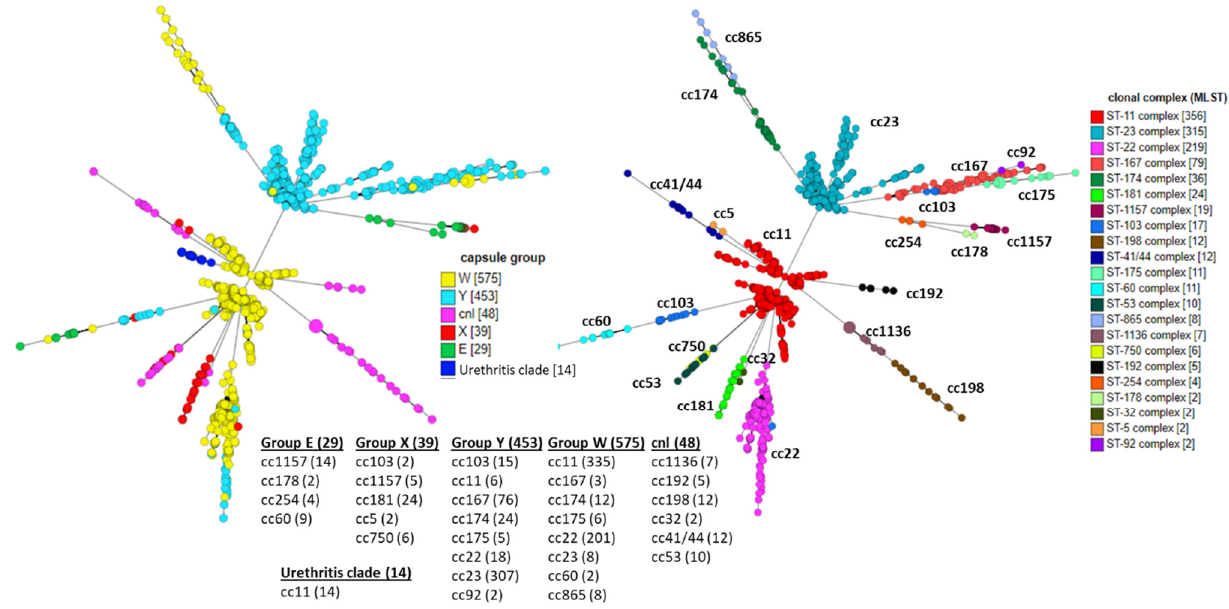
Figure 1. Meningococcal invasive isolates of capsule groups E, W, X, Y, nongroupable cnl, and urethritis clade isolates that have whole genome sequencing data and “disease” record entries of “invasive,” “meningitis,” “septicemia,” or “meningitis and septicemia” were retrieved from PubMLST database (http://pubmlst.org/neisseria/, access on 2 March 2021). Isolates without records of “year” and “clonal complex” were excluded. A single isolate that has a unique combination of country/year/sequence type (ST) definition was selected and the clonal complexes with at least two isolates were included in the analysis. The minimum spanning trees were generated and visualized with GrapeTree [103], a plug-in analysis tool at PubMLST, with the scheme of N. meningitidis core genome MLST (cgMLST) v 1.0 and default parameters. The trees are colored by capsular groups ( left ) or clonal complexes ( right ). The clonal complex breakdowns of each capsule groups are also